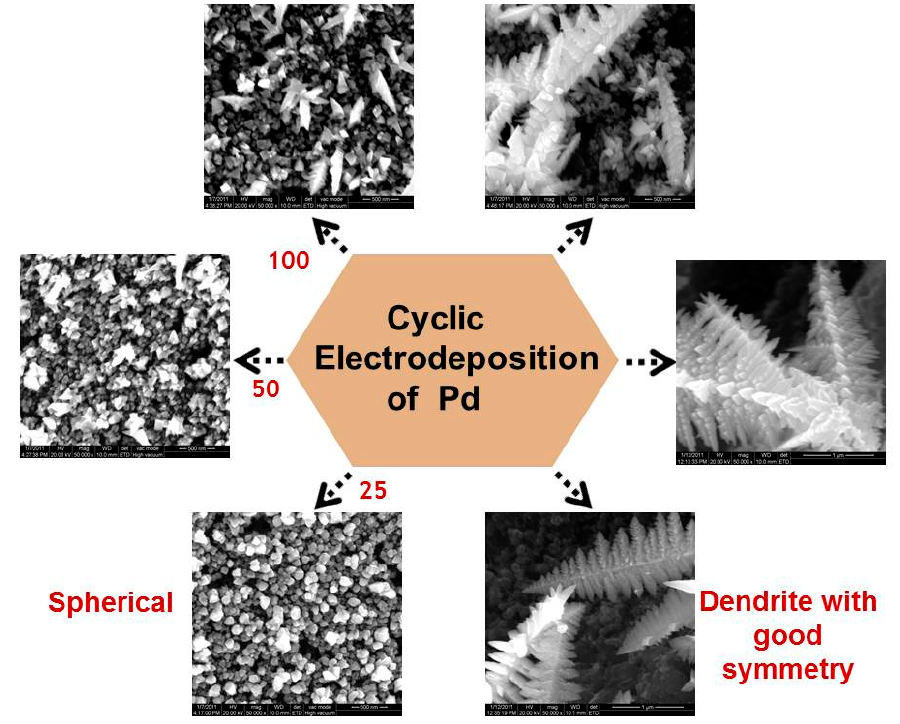
Figure 7. Scanning electron micrographs showing the morphological transitions of palladium sup- ported on Vulcan. Reproduced with permission from